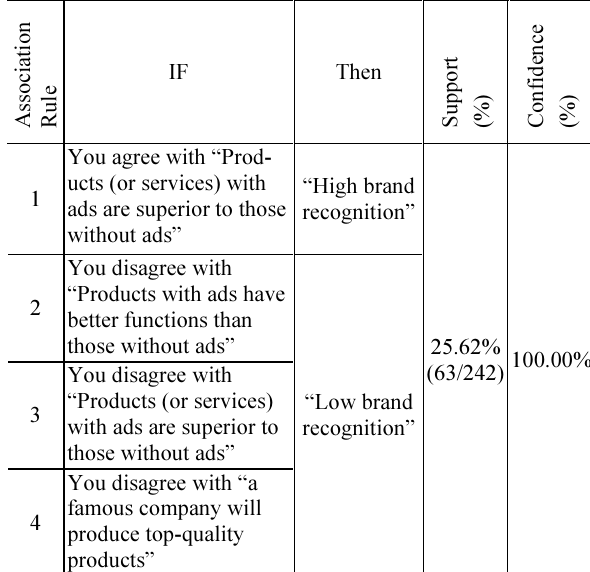
Table 4. Results of Association Rules for Brand Recognition